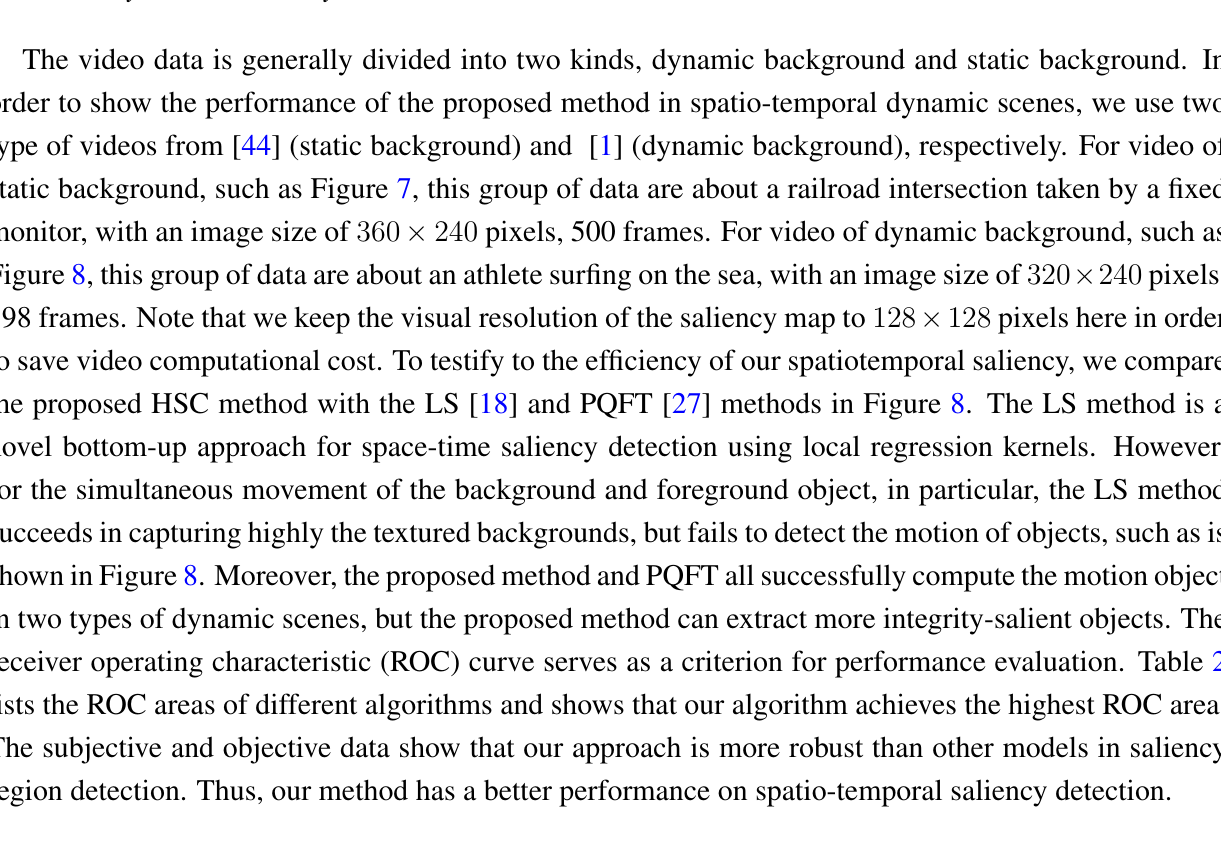
Comparison of two methods of spatio-temporal saliency maps in video sequences (static background). The first row is the raw video [44]; the second to fourth